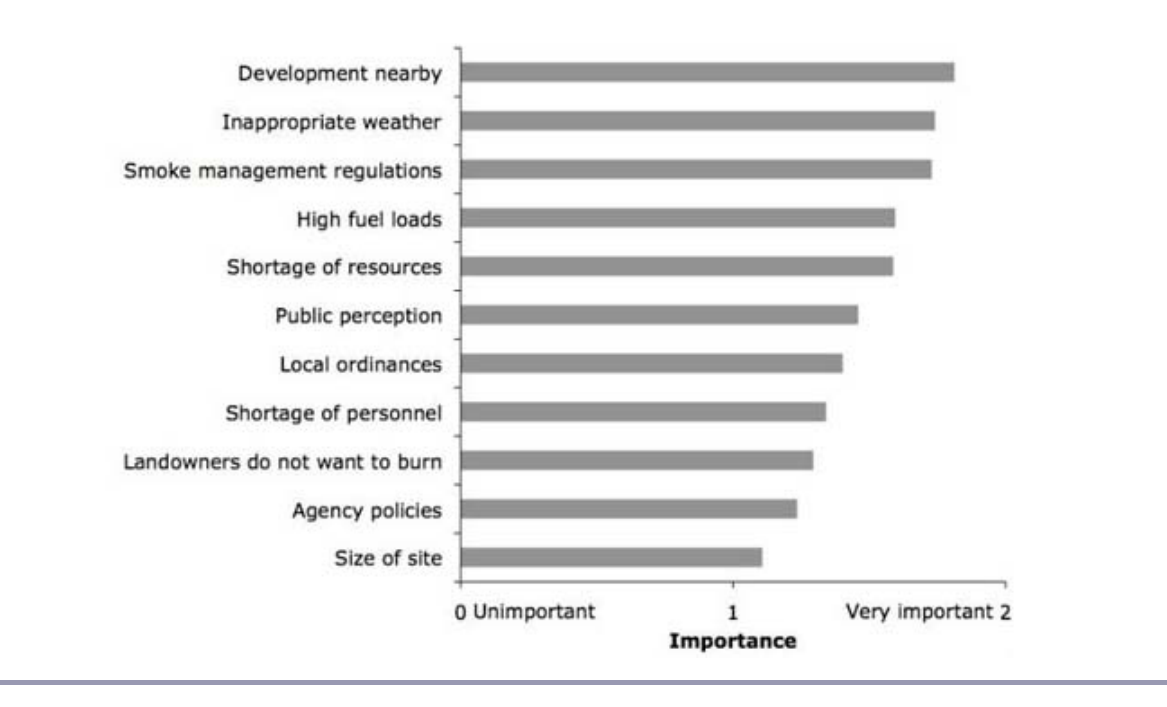
Fig. 2. Constraints on burning and their mean importance for all